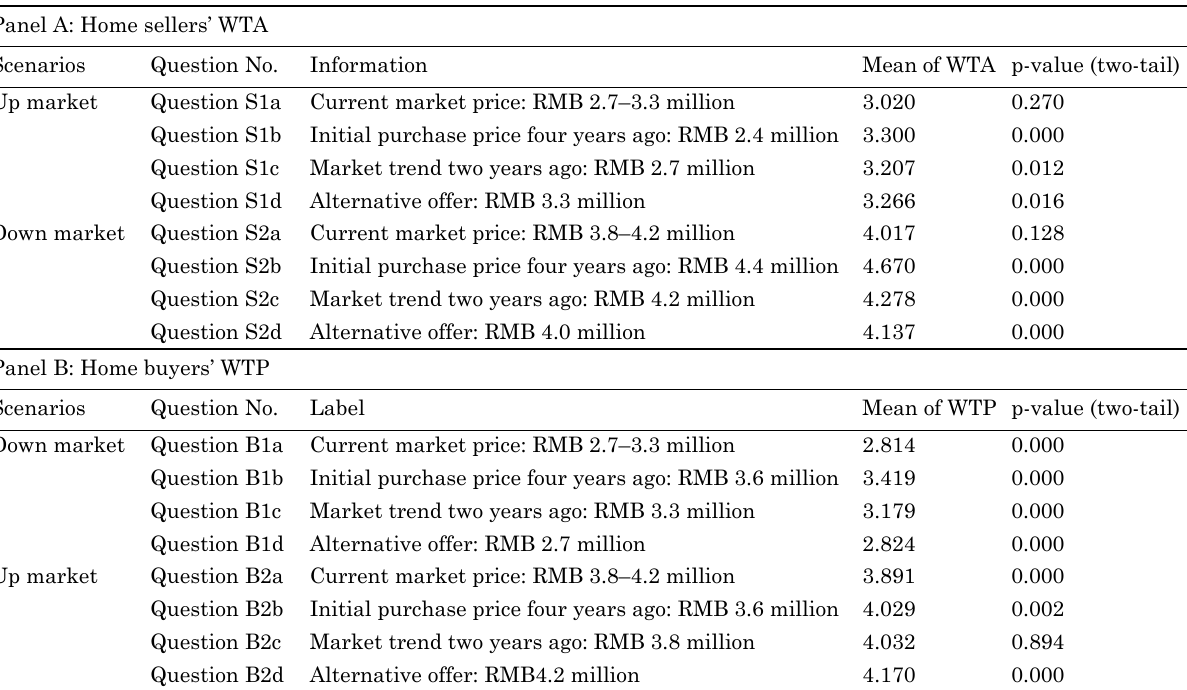
table 2. Questionnaire design and summary statistics Panel A: Home sellers’ WTA